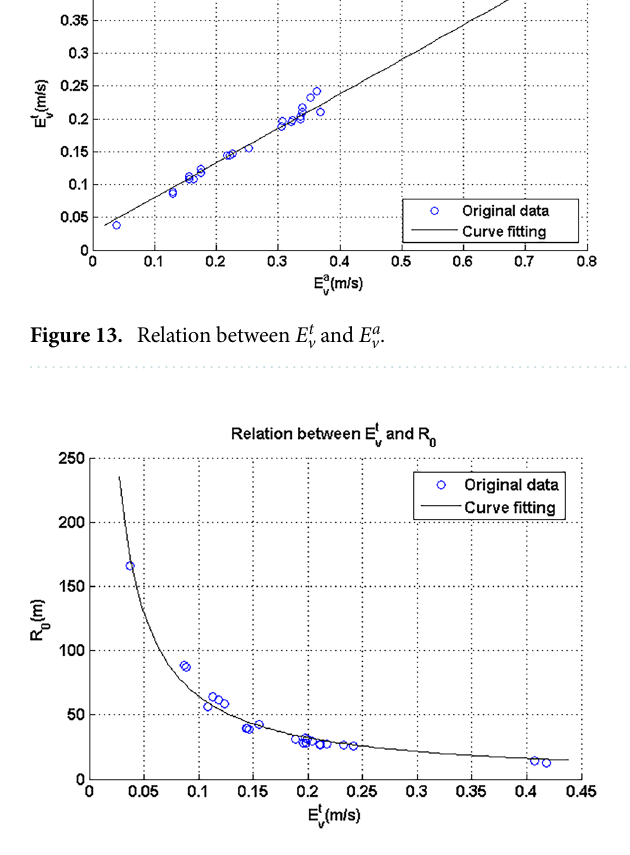
Figure 14. Relation between E t v and R 0